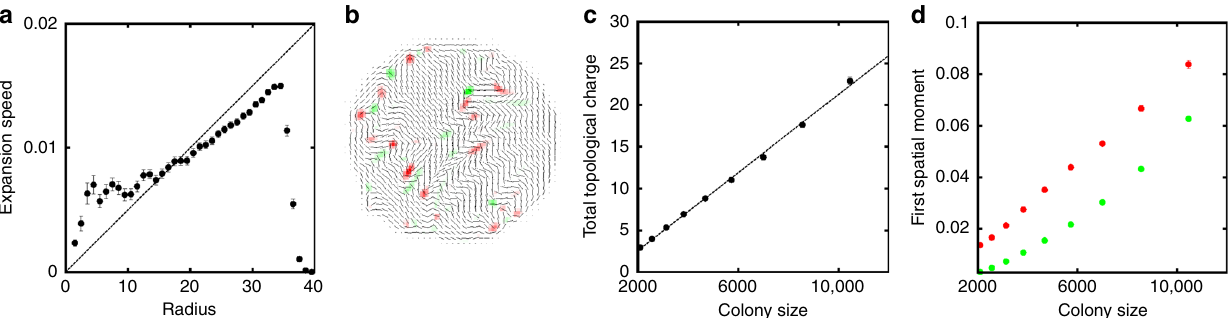
Fig. 6 Simulations of 2D colony growth. a Plot of the azimuthually-averaged radial velocity within the colony, as a function of distance from the centre of the simulation box (both quantities are measured in simulation units). The dashed line indicates the ‘ Hubble ’ prediction, v = Λ /2 r . The sharp drop in the curve at large radius corresponds to the change from inside the colony to outside. b Director fi eld pattern and topological charge density (red, positive; green, negative) for a growing colony at a late time in the simulation. c Plot of the total unsigned topological charge simulation units). Filled circles: average over 10 simulated colonies (errors are standard error of the mean). Dashed line: linear fi t. d Red circles: fi rst spatial moment of positive topological charges in the colony versus colony area (in simulation units). This quantity is computed as denotes that integration/summation only involves points with q > 0. Green circles: analogous quantity for negative topological charges. Parameters are: Λ = 0.001, a = 0.02, G = γ = ρ = 1, α ¼ ^ K ¼ 0 : 01, ξ = 0.7. Simulations were initialised with a radius of 10 simulation units, and the Q-tensor equal to zero 0 0 0 with some small noise. In a , c , d error bars are standard errors of the